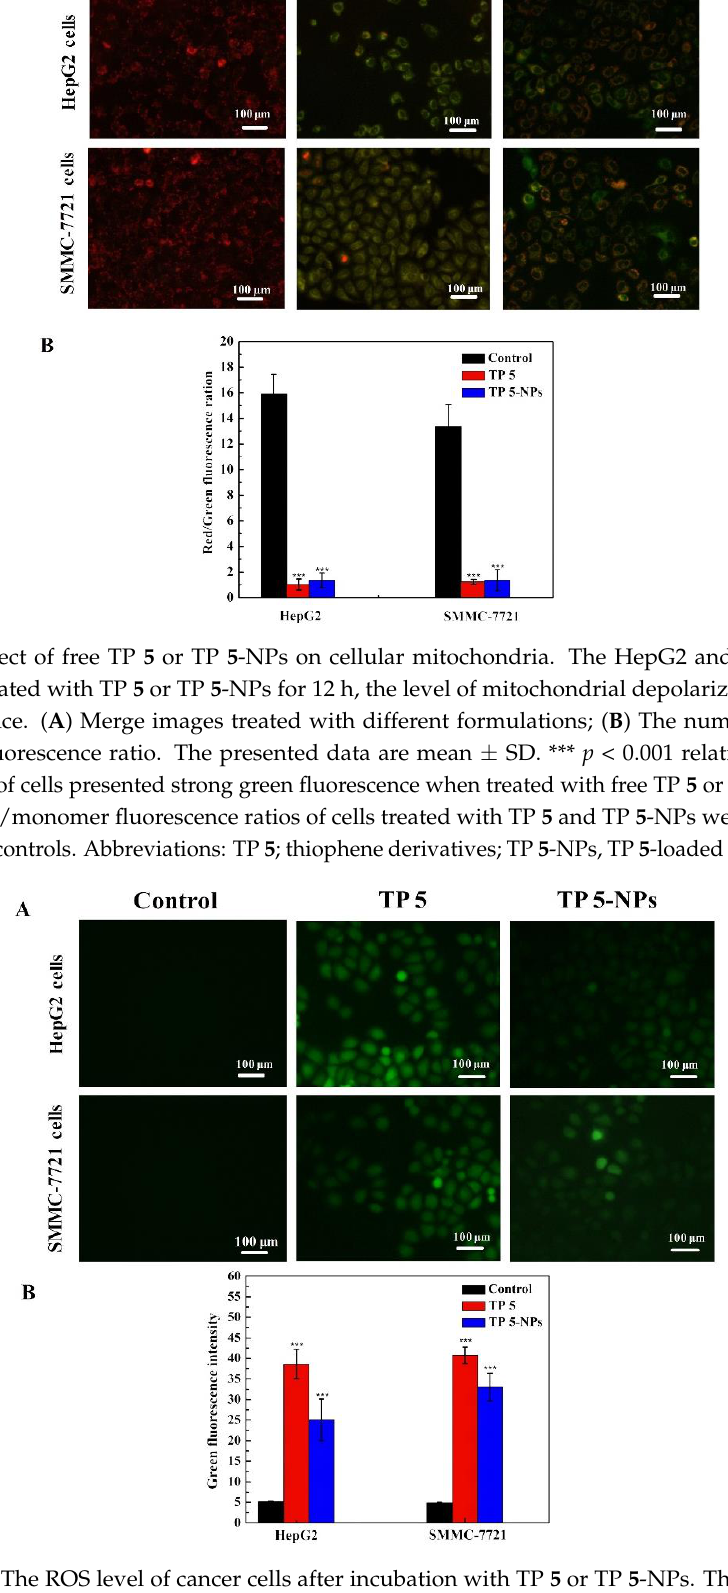
Figure 8. ( A ) The ROS level of cancer cells after incubation with TP 5 or TP 5 -NPs. The HepG2 and SMMC-7721 cells were treated with TP 5 or TP 5 -NPs for 12 h, ( B ) the ROS level showed by fluorescence. The presented data are mean ± SD. *** p < 0.001 relative to control. Free TP 5 and TP 5 -NPs treated cells presented bright green fluorescence, indicating that the levels of ROS induced by free TP 5 and TP 5 -NPs were higher than control cells . Abbreviations: TP 5 ; thiophene derivatives; TP 5 -NPs, TP 5 -loaded nanoparticles. 3. Discussion Recently, TPs have attracted considerable attention due to their high antitumor activity [3,4]. But low solubility and nonspecific limit its application or result in its poor curative effect, high toxic for healthy tissues or side-effect including lesions in the gastrointestinal tract, hair loss and nausea [7]. In this work, the cytotoxicity of 6 TPs was evaluated by MTT assay. According to the IC 50 of paclitaxel (35.92 μg/mL for HepG2 and 35.33 μg/mL SMMC-7721at 24 h), 30.0 μg/mL of TPs was employed to evaluate their cytotoxicity. By comparison, TP 5 presents high antitumor activity. In order to improve its solubility and tumor bioavailability, HSA, as a drug carrier, plays a significant role in TP 5 -loaded self-assembling nanoparticle, which is expected to result in fewer side effects for health tissue than free TP 5 . For the synthesis of TP 5 -NPs, the fate of TP 5 -NPs was determined by temperature and the concentration of TP 5 . Therefore, temperature and the concentration of TP 5 were discussed in this work. It can be seen from Table 3 that the particle size was large and the dispersibility was unsatisfactory when the temperature was 25 °C and the concentration of TP 5 was 2.0 mg/mL, which may be attributed to the limitation of solubility. Higher temperature contributes to the unfolding of protein chains and the hydrophobic groups were exposed. Besides, higher temperature results in the larger size of nanoparticles and a larger amount of TP 5 covalent linked with HSA [1]. Therefore, the particle size of TP 5 -NPs prepared at 60 °C was all larger than prepared at 40 °C. However, increasing concentration of TP 5 induced reduction of the mean diameter of TP 5 -NPs, which may be attributed to stronger force between TP 5 and NPs. The concentration of TP 5 was increased and the structure of TP 5 -NPs become more integrated [27]. In addition, due to the low solubility of TP 5 , TP 5 -NPs obtained at a concentration of 5.0 mg/mL at 40 °C and 7.0 mg/mL at 60 °C were all unsatisfactory. The average particle size of TP 5 -NPs under the recommended optimum conditions was 205.4±3.44